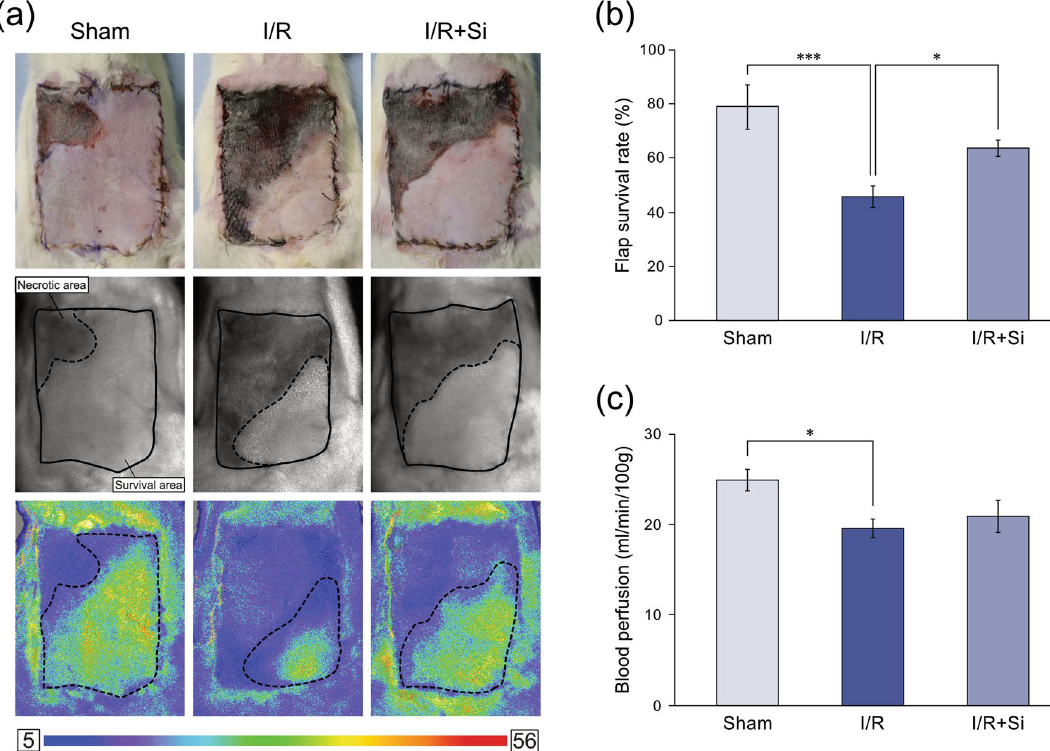
Figure 2. Postoperative skin flap survival and blood flow. ( a ) Representative images of each group, along with blood flow images obtained using the laser speckle blood flow imaging system. Solid lines show the original flap area and dashed lines show the surviving flap areas. ( b ), ( c ) Flap survival rate and blood perfusion after ischemia–reperfusion injury (* p < 0.05, *** p < 0.001; Tukey’s HSD multiple comparisons test, bars represent standard errors of